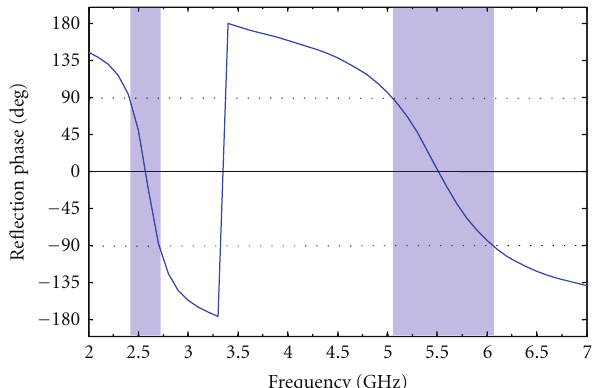
Figure 13: Simulated reflection phase of the AMC